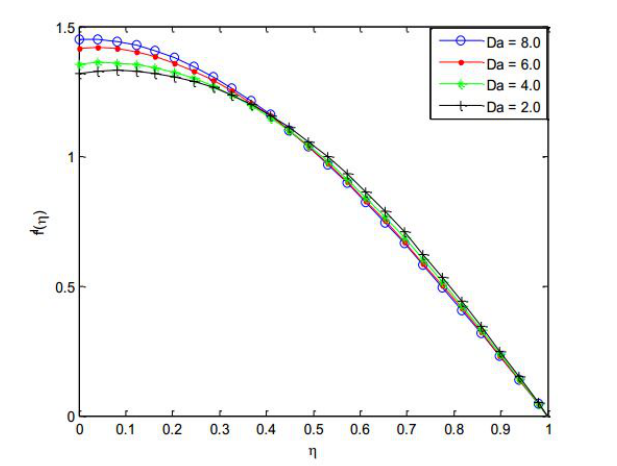
Figure 5. Effects of Darcy number on the velocity